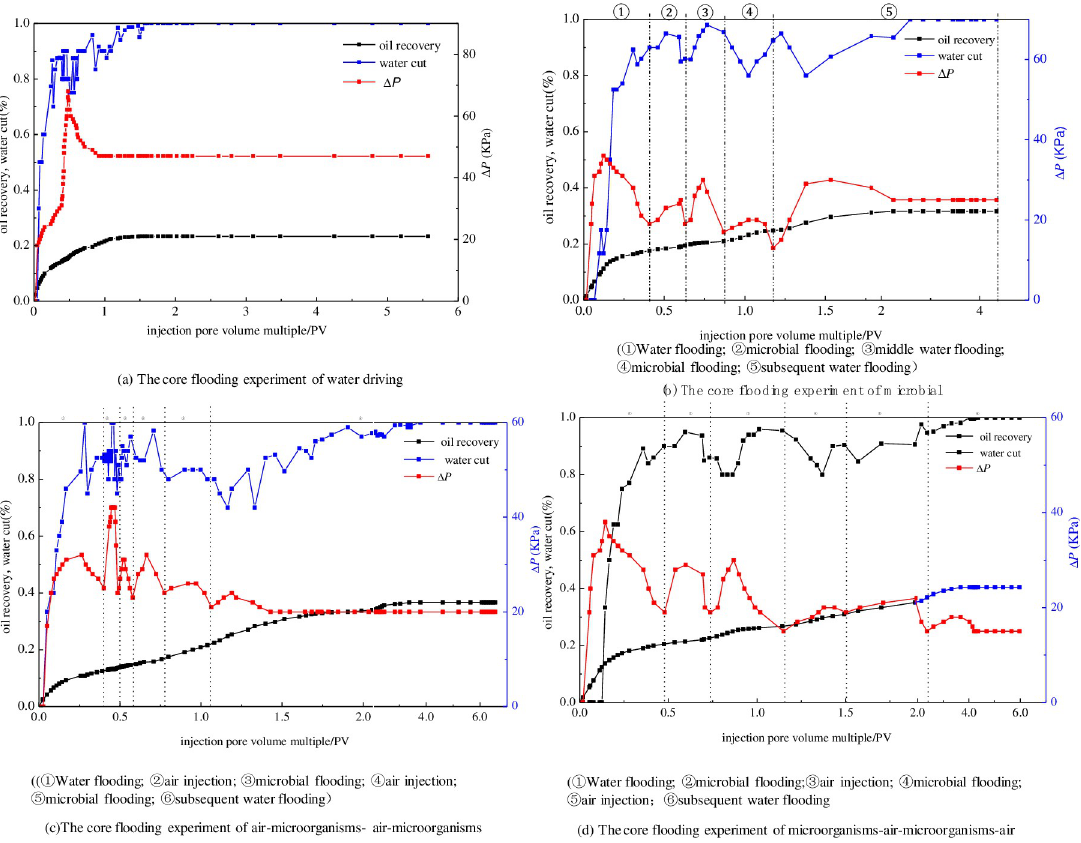
Fig 10. The core flooding experiment of water driving under the condition of